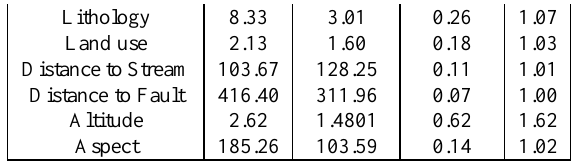
Table 1. The estimated Variance Information Factor (VIF) for landslide conditioning variables.